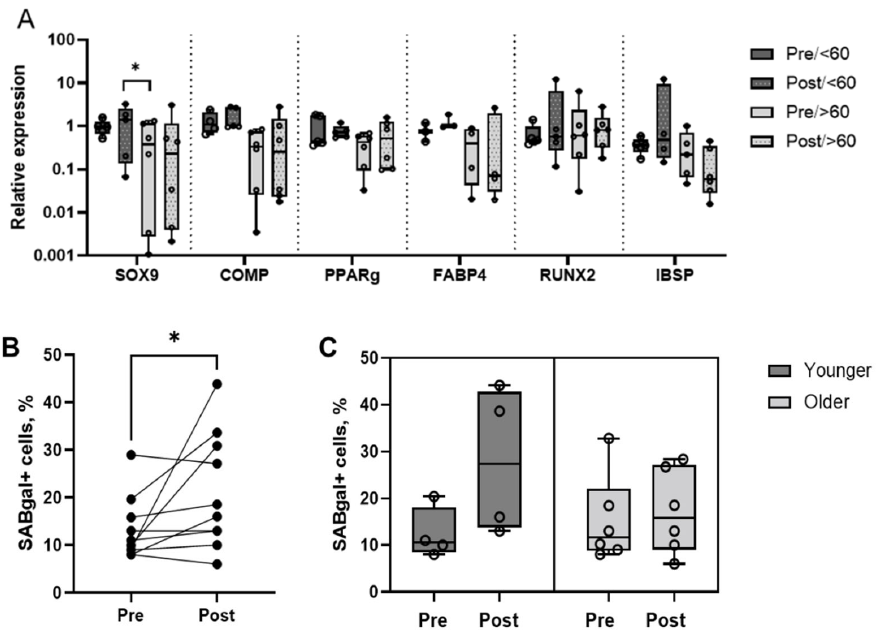
Figure 2. The MSC multipotentiality marker expression and the proportions of senescent cells in p1 MSCs before (Pre) and 2 weeks after (Post) PRP infiltrations. ( A ) Relative expression of SOX9 , COMP, PPAR γ , FABP4, RUNX2 , and IBSP in the Pre and Post samples segregated by age. ( B ) Comparison of senescent cell percentages in the Pre and Post samples (all patients). ( C ) Comparison of the senescent cell percentages in the Pre and Post samples (patients segregated by age). Circular symbols in all panels represent individual patients, horizontal bars on C represent medians, * p < 0.05, Wilcoxon rank sum test.